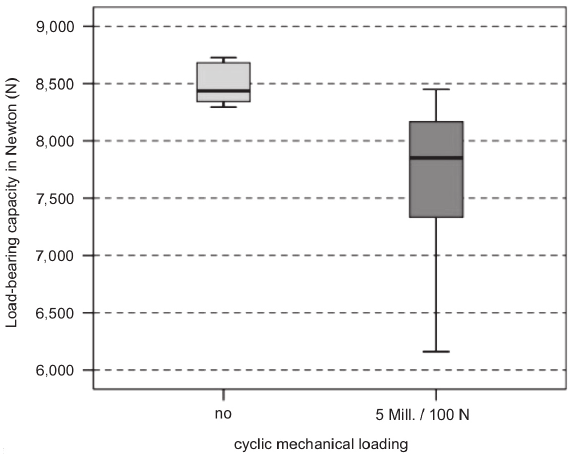
Figure 6- Box chart representing load-bearing capacity for both test groups. Medians and quartiles are given